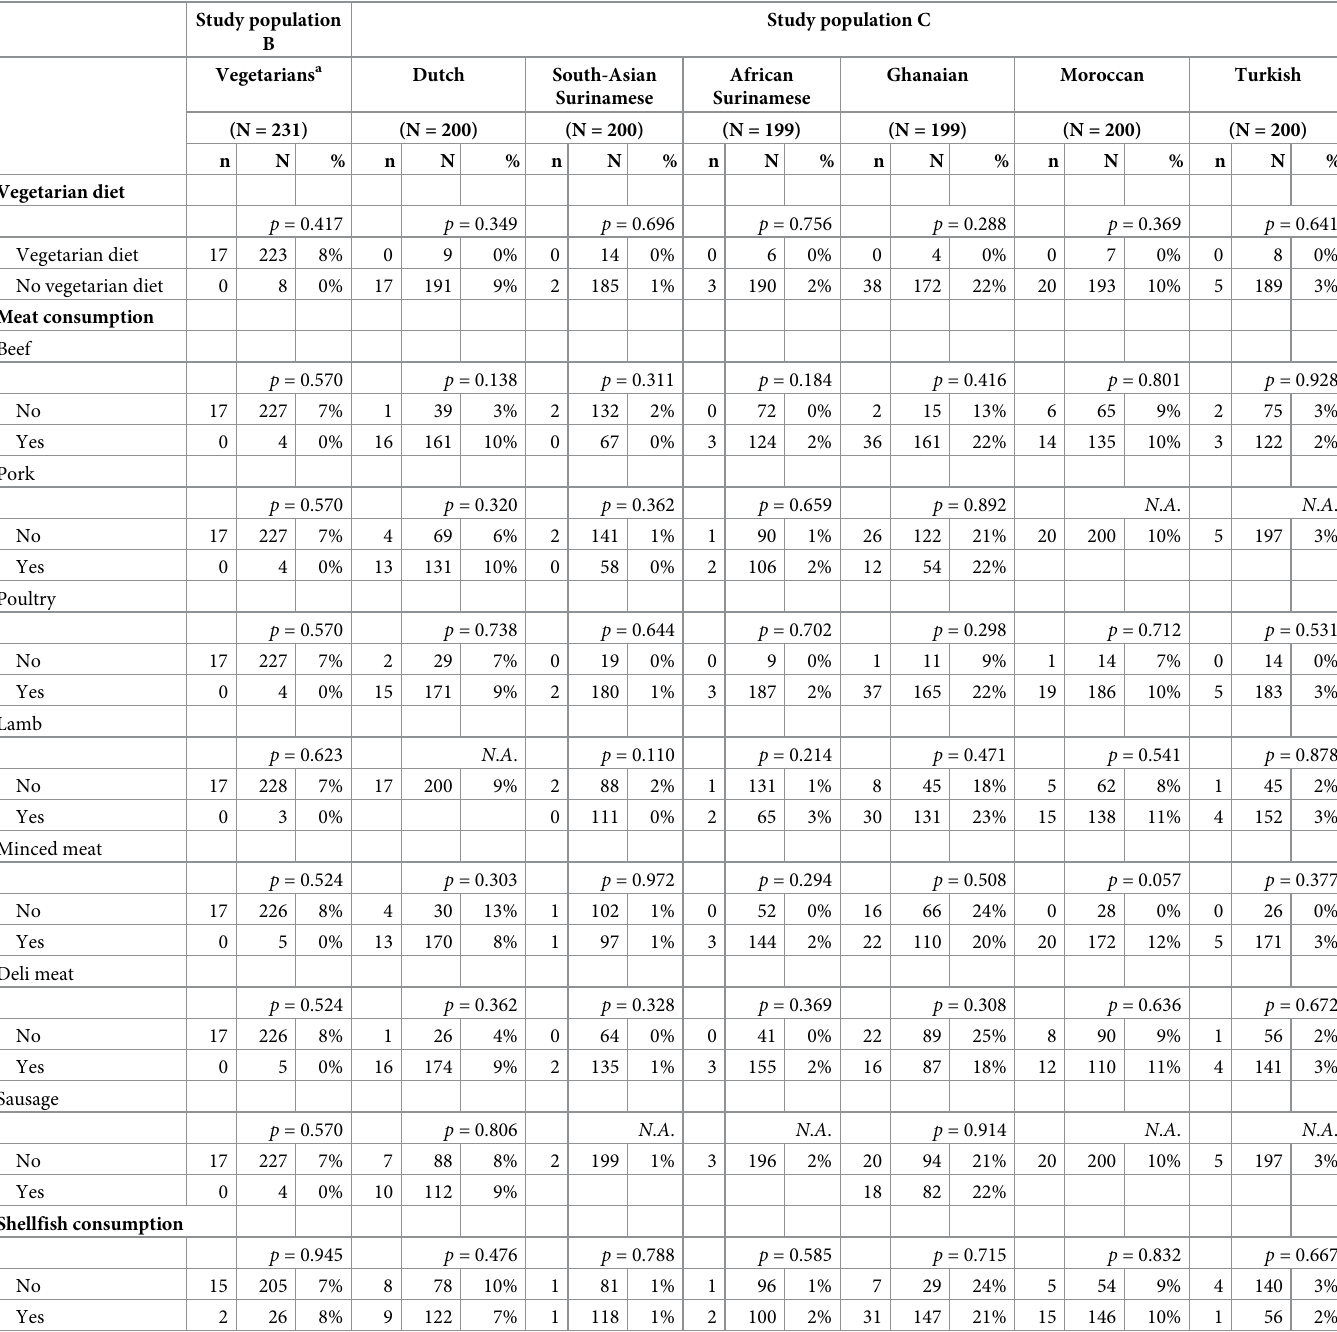
Table 3. Meat and shellfish intake in the preceding 1–12 months by IgG HEV among various study populations from the